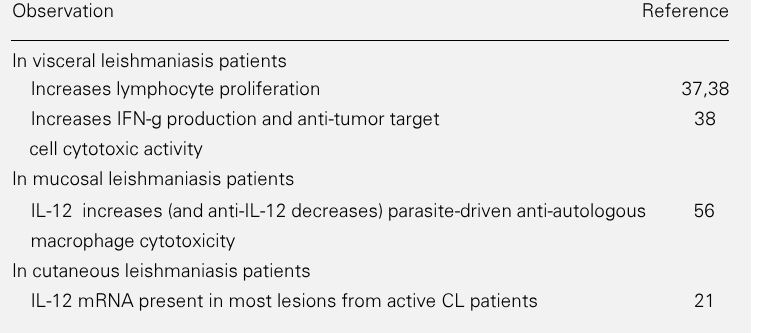
Table 2 - IL-12 in human